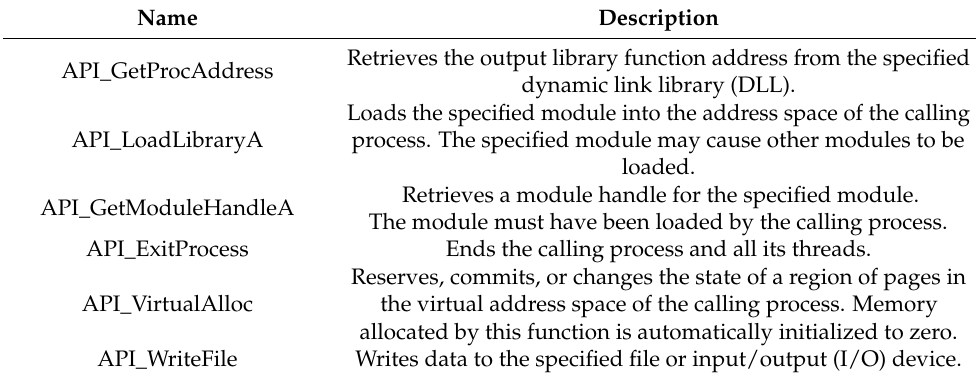
Table 3. API interface